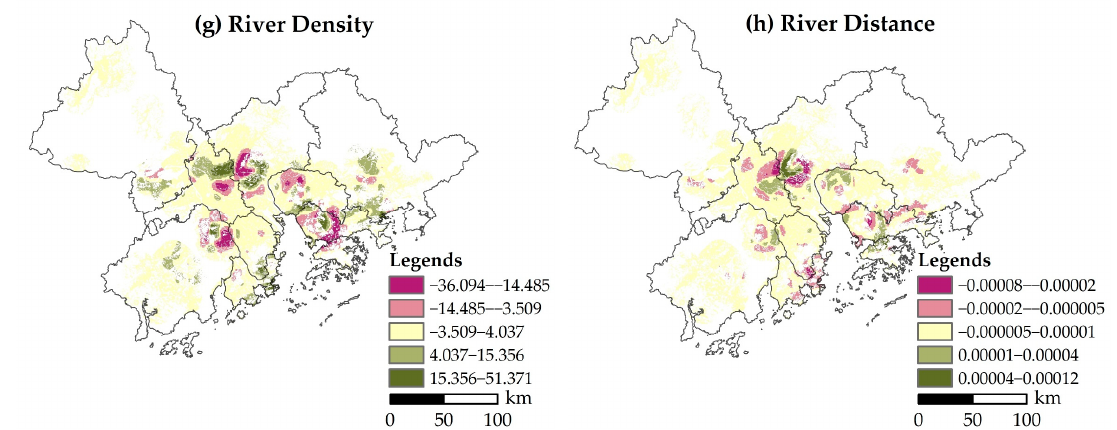
Figure 7. Spatial distribution of regression coefficients from GWR. Table 4. The result of